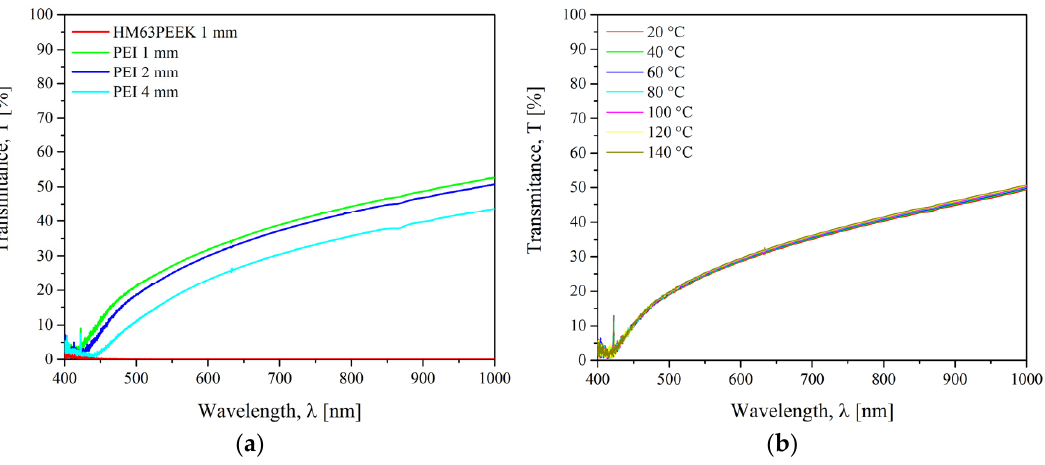
Figure 10. Transmission coefficient of ( a ) PEI and HM63/PEEK at 20°C and ( b ) PEI for different temperatures.